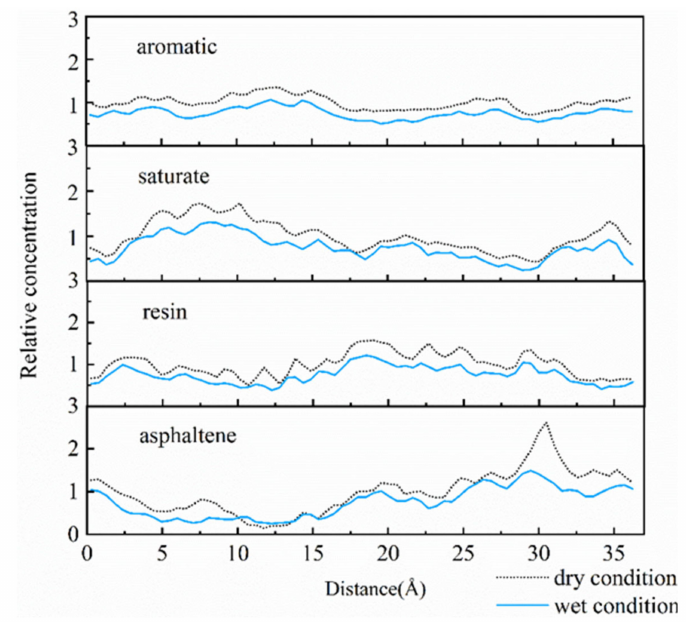
Figure 3. Relative concentrations of the asphalt-calcite interface system.